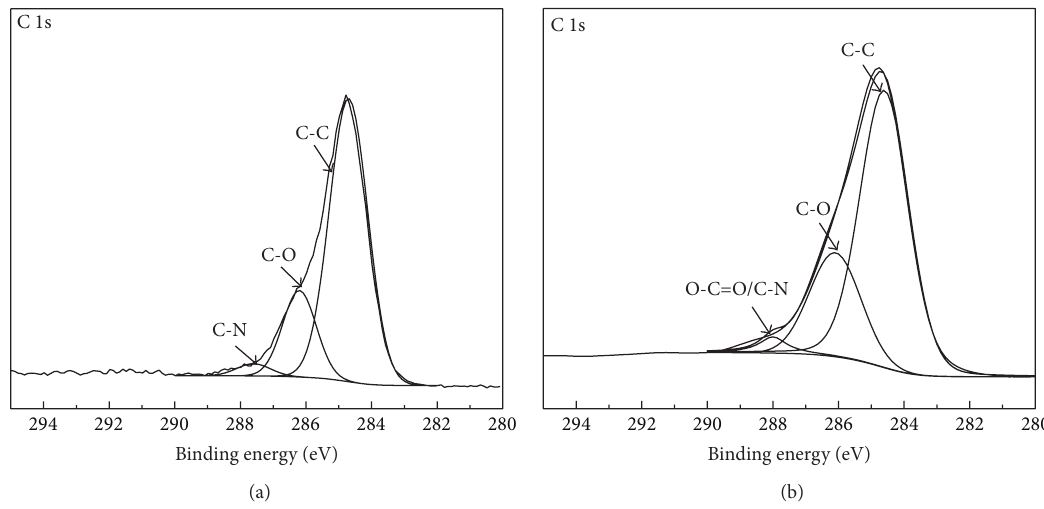
Figure 2: The XPS spectra of C 1s for (a) M-PES and (b)